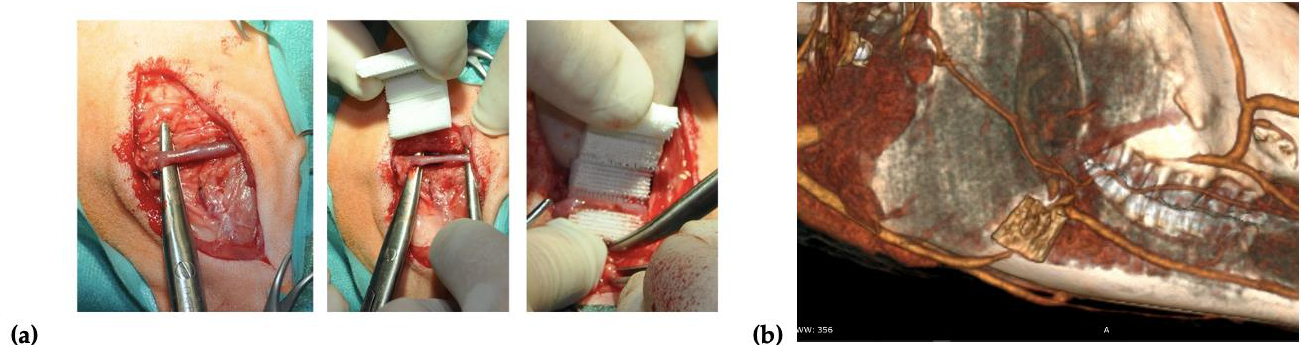
Figure 1. ( a ) Scaffold implantation in the masseter muscles, around the facial vein. ( b ) A tomogra- phy scan performed immediately after the implantation